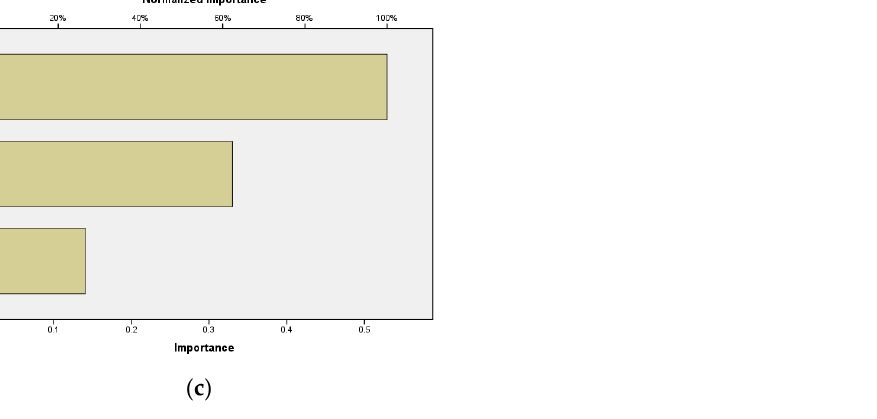
Figure 16. ( a ) Experimental vs. predicted values of the samples; ( b ) error-values; ( c ) normalized factor importance.